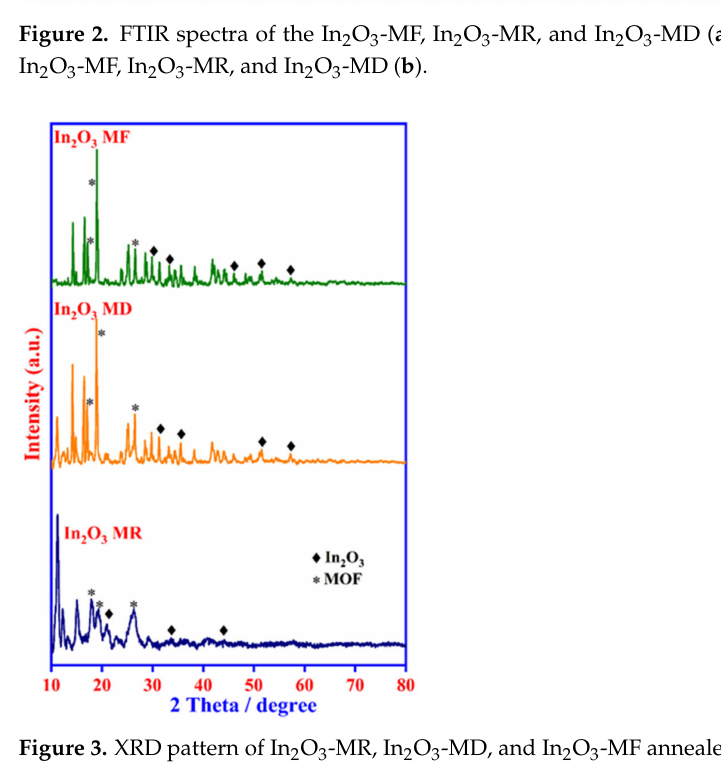
Figure 3. XRD pattern of In 2 O 3 -MR, In 2 O 3 -MD, and In 2 O 3 -MF annealed at 300 ◦ C. N 2 adsorption–desorption analysis was used to evaluate the porous structure of In 2 O 3 -MF. They have a mesoporous structure, as shown in Figure S3, and their pore size distribution ranges from nanometer to macroscale. The micropore and mesopore distribution, as measured by the HK and BJH techniques, was used to confirm the pore structure [44]. Table S1 summarizes the BET surface area of In 2 O 3 -MF, In 2 O 3 -MD, and In 2 O 3 -MR. When compared to In 2 O 3 -MD and In 2 O 3 -MR, In 2 O 3 -MF has the greatest BET surface area of 486.95 m 2 g − 1 . As a result, the In 2 O 3 -MF large surface area will be enriched with active sites for photocatalysis. The optical properties of synthesized catalyst samples were analyzed using UV–DRS. The band gaps in the In 2 O 3 -MF, In 2 O 3 -MD, and In 2 O 3 -MR samples were calculated using the Tauc’s equation